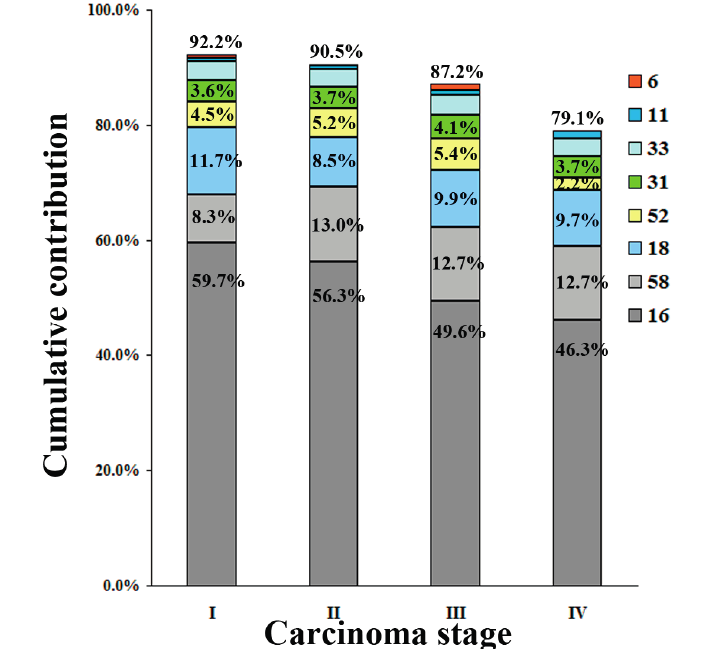
Figure 4. Cumulative contribution of the six most common HPV types for each stage of invasive cervical cancer (ICC). HPV-16 attributed to the majority of ICC, and marginal attribution rates conferred by individual HPV types and cumulative attribution rates are